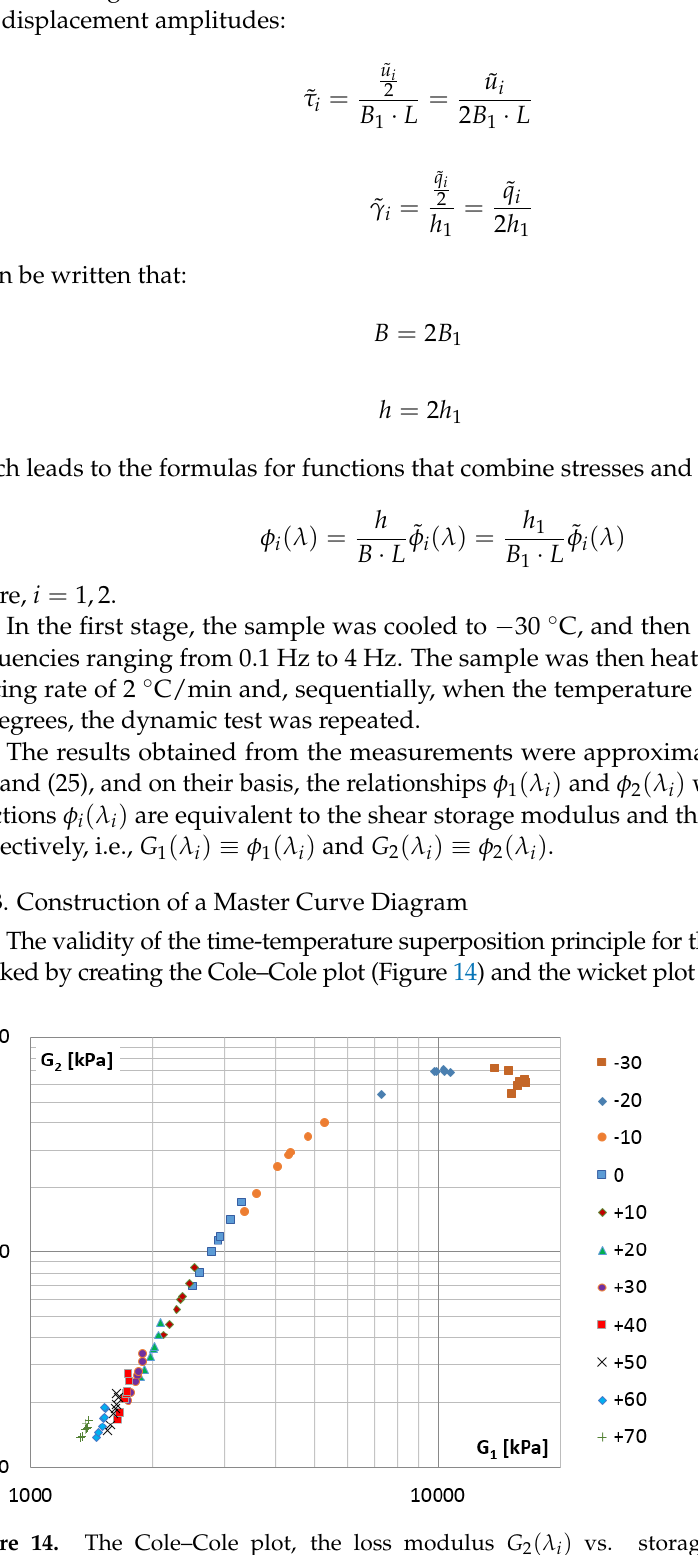
Figure 14. The Cole–Cole plot, the loss modulus G 2 ( λ i ) vs. storage modulus G 1 ( λ i ) for selected